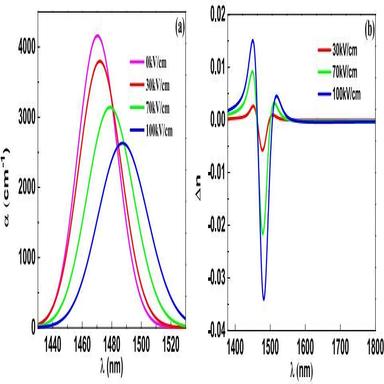
(a) Absorption spectrum in a 75 Åwide QW at applied fields 0 kV/cm, 30 kV/cm, 70 kV/cm and 100 kV/cm, (b) Refractive index change at the different fields in 75 ÅQW.